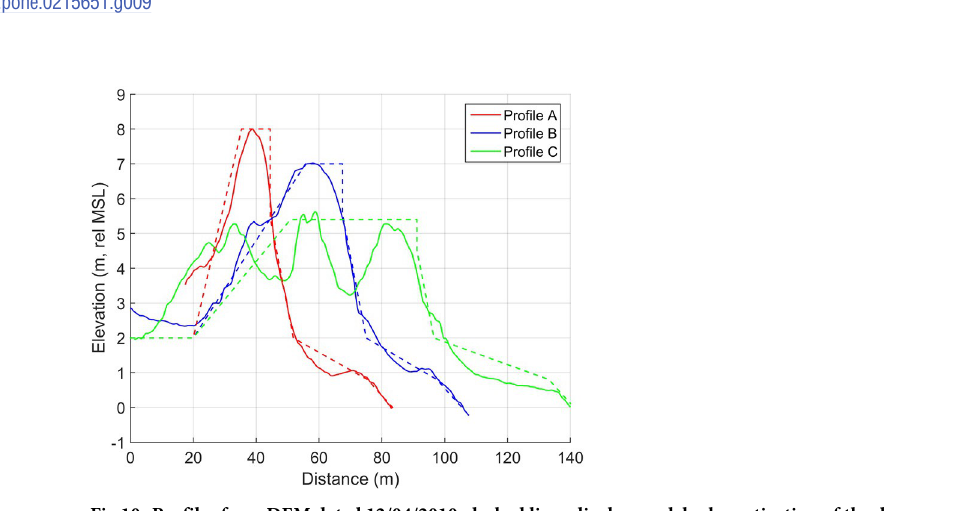
PLOS ONE | https://doi.org/10.1371/journal.pone.0215651 April 19,